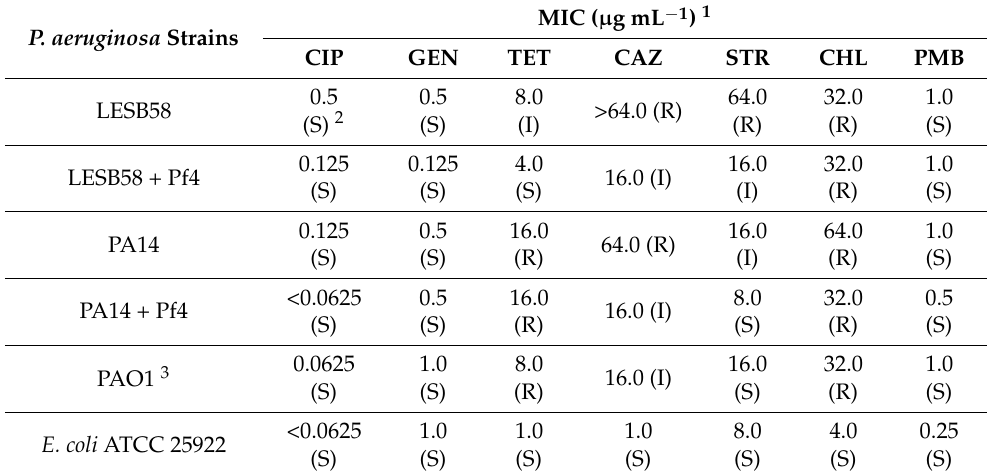
Table 1. MIC of antibiotics for uninfected and Pf4-infected P. aeruginosa strains. P. aeruginosa